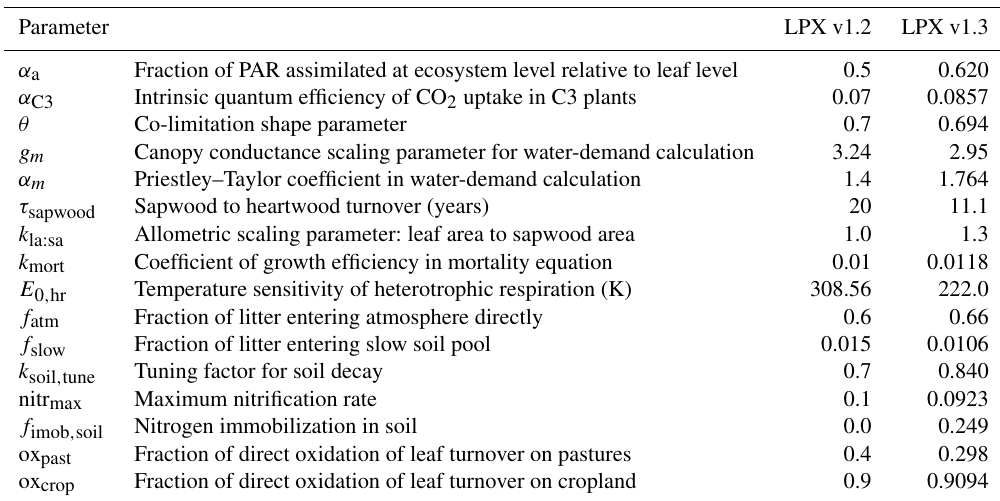
Table 1. Parameter values of LPX-Bern that were modified from the previous model version (LPX v1.2) and as used in this study (LPX v1.3). The new values were determined by maximizing agreement with a set of observational data.